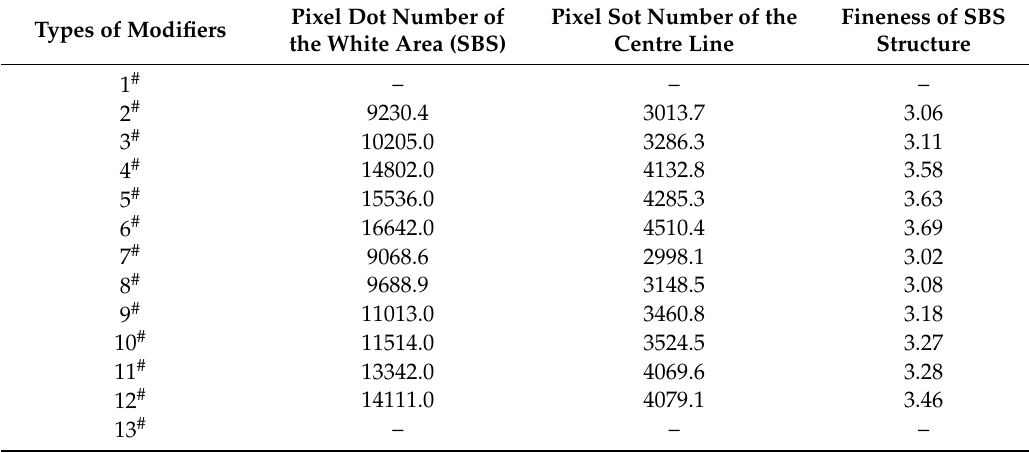
Table 4. Computing results of different kinds of direct-to-plant SBS modified bitumen.